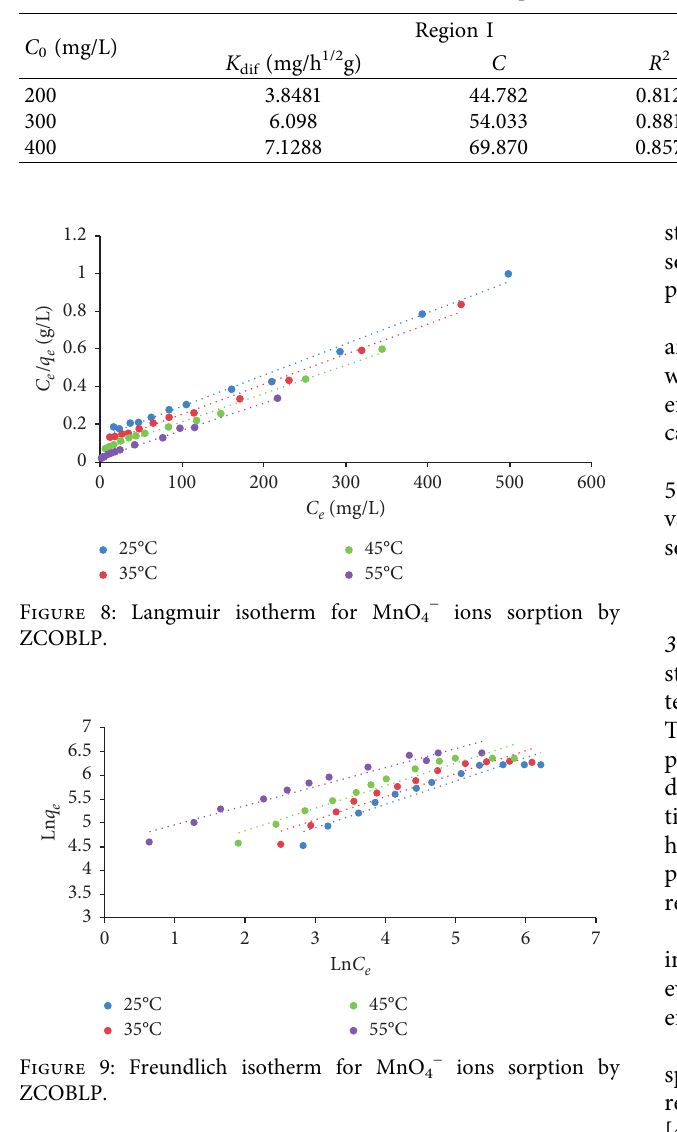
− ions sorption by 4